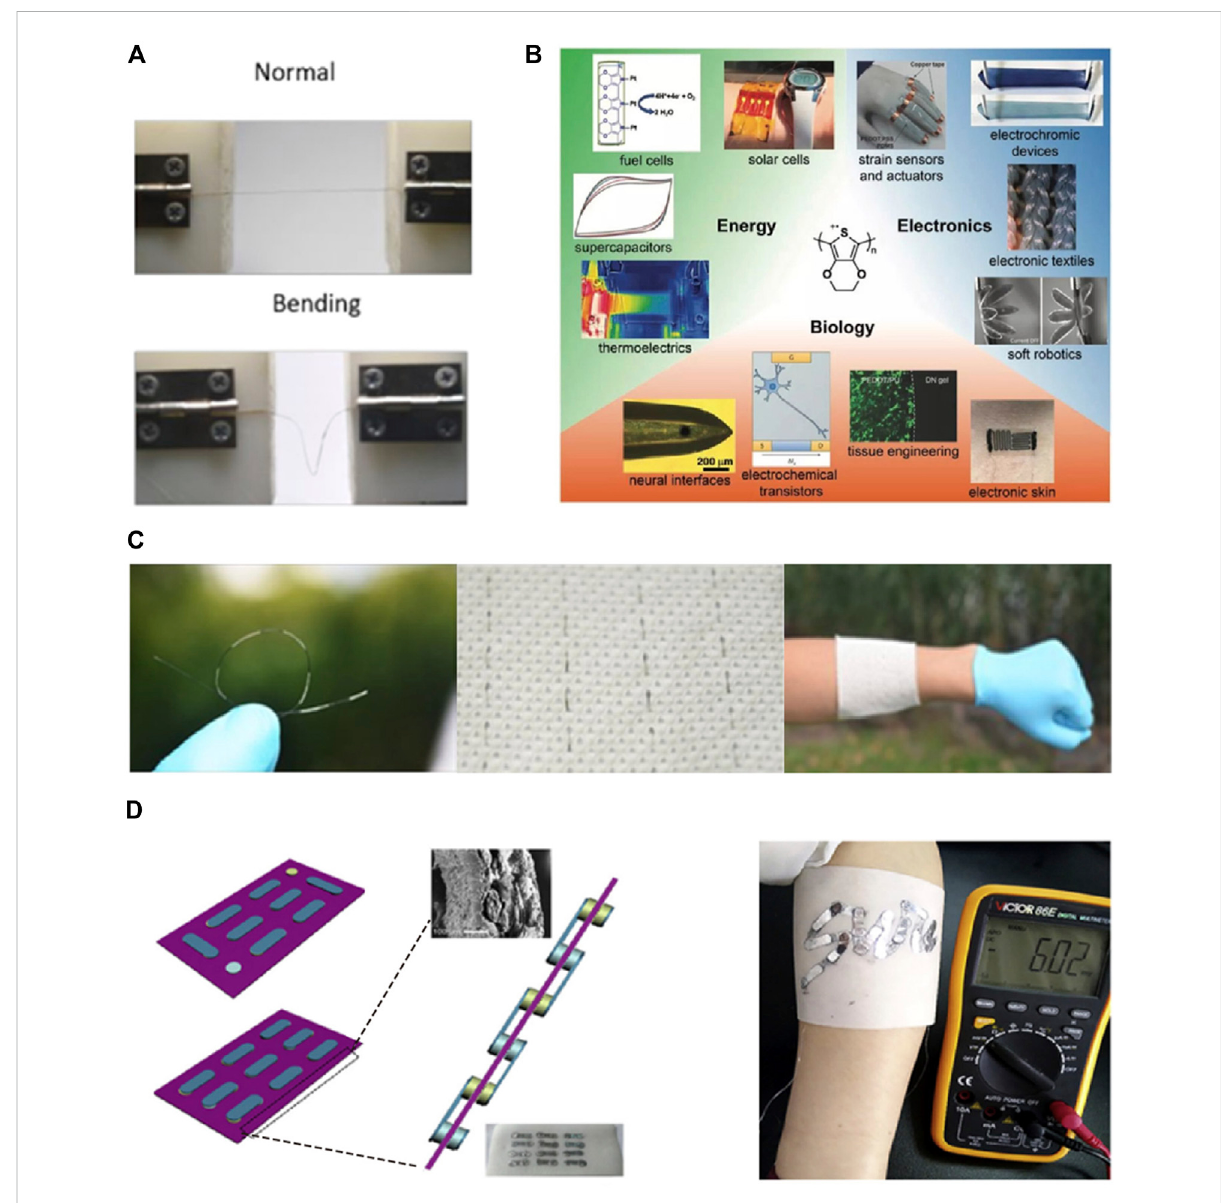
FIGURE 1 (A) Photos showing the bending of the composite fi bre, based on PEDOT (The radius of curvature is about 1.4 mm) (Xu et al., 2020). (B) ApplicationsofstretchableconductivePEDOT:PSS inenergy,electronicsandbiology(KayserandLipomi,2019). (C)